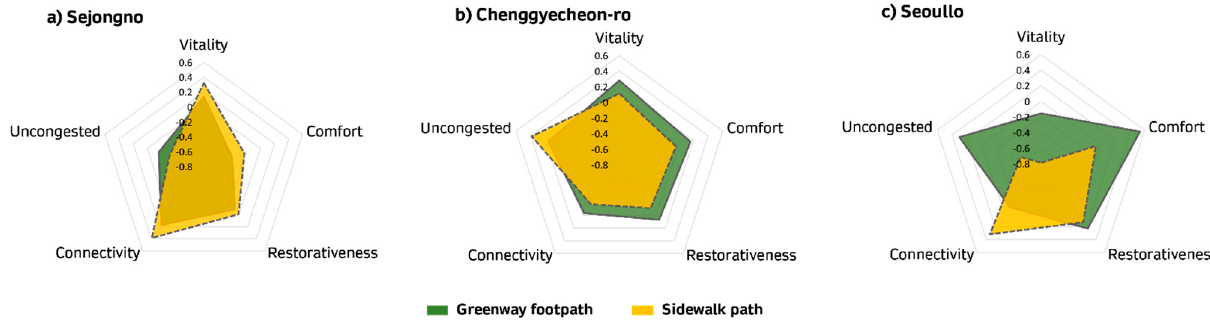
Figure 3. Radar chart comparing street perceptions.